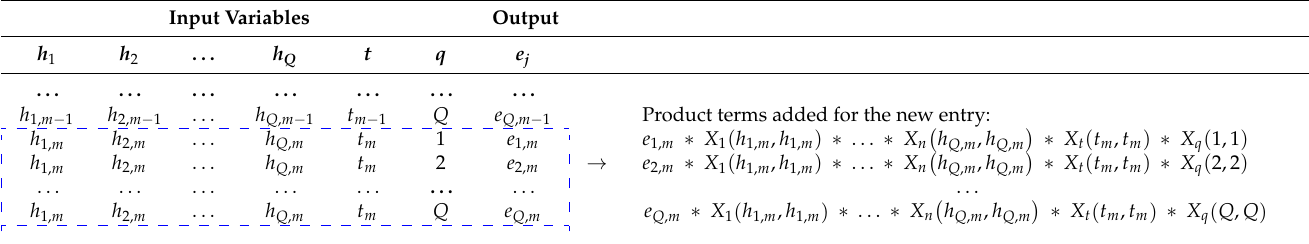
Table 2. The supplementation of the newcomer entry e m = ( e 1, m , . . . , e n , m ) to the truth table of the storage function F sth and the formation of corresponding product terms (shown to the right). Previous entry is e m − 1 = ( e 1, m − 1 , . . . , e n , m − 1 ) , the overall number of verifiers is Q . Service variables t and q respond to the time stamp and the counter of verifiers.